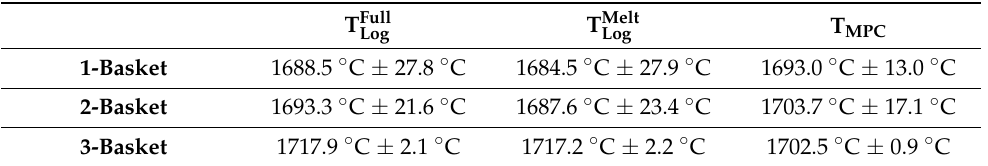
Table 4. Temperature of fully-liquefied steel prior to tapping as predicted by the model when follow- ing logged process data and MPC simulations. Both means and standard deviations are